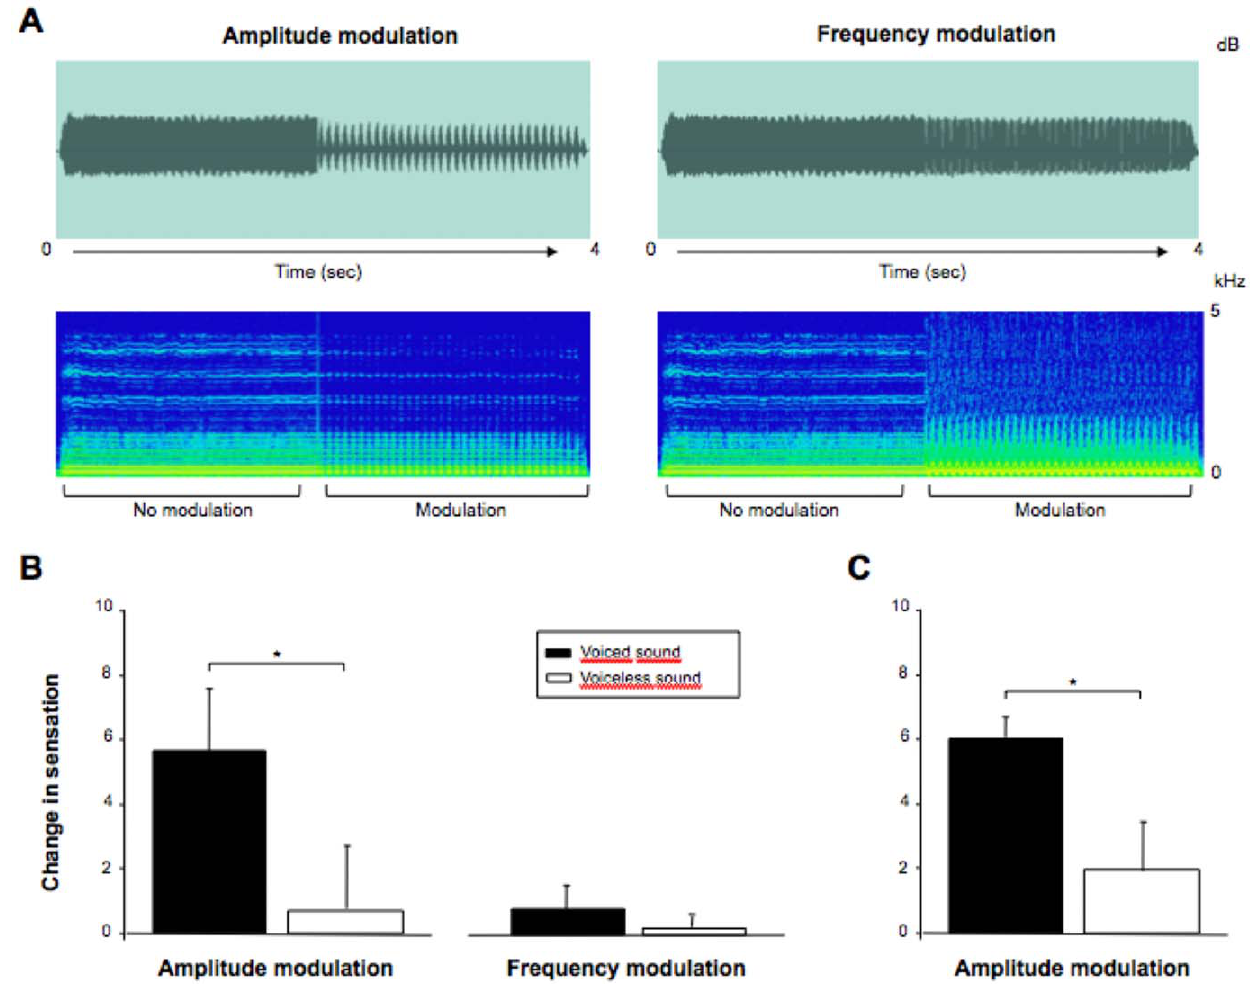
Figure 1. Experimental procedure and mean change in tactile sensation in twenty-two participants. (A) Illustration of the experimental procedure in the active production-listening task. Participants were seated close to a microphone and were repeatedly asked to produce different phonemes for a period of approximately four seconds. The auditory signal from the first two seconds of each phoneme production was not modified whereas the last part of the audio signal was altered in amplitude (left panel) or in frequency (right panel). Top panel shows waveforms (amplitude as a function of time) while bottom panels show spectrograms (frequency as a function of time). (B) Mean change in tactile sensation over the lips region (n=15) or (C), the throat/larynx region (n=7) and standard deviations while producing the voiced (black bar) and the voiceless sound (white bar). * : p , .005.